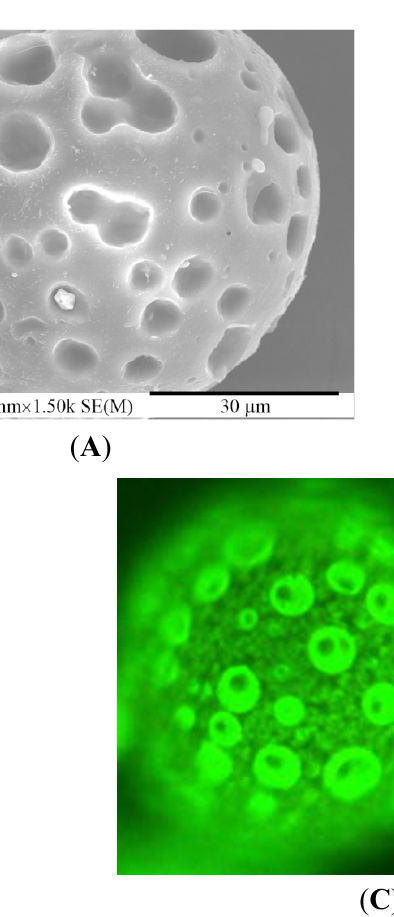
Figure 6. Microscope images of PLGA microparticles. ( A ) and ( B ) are SEM images. ( C ) is fluorescent image. The size of the sphere is 60 μ m.